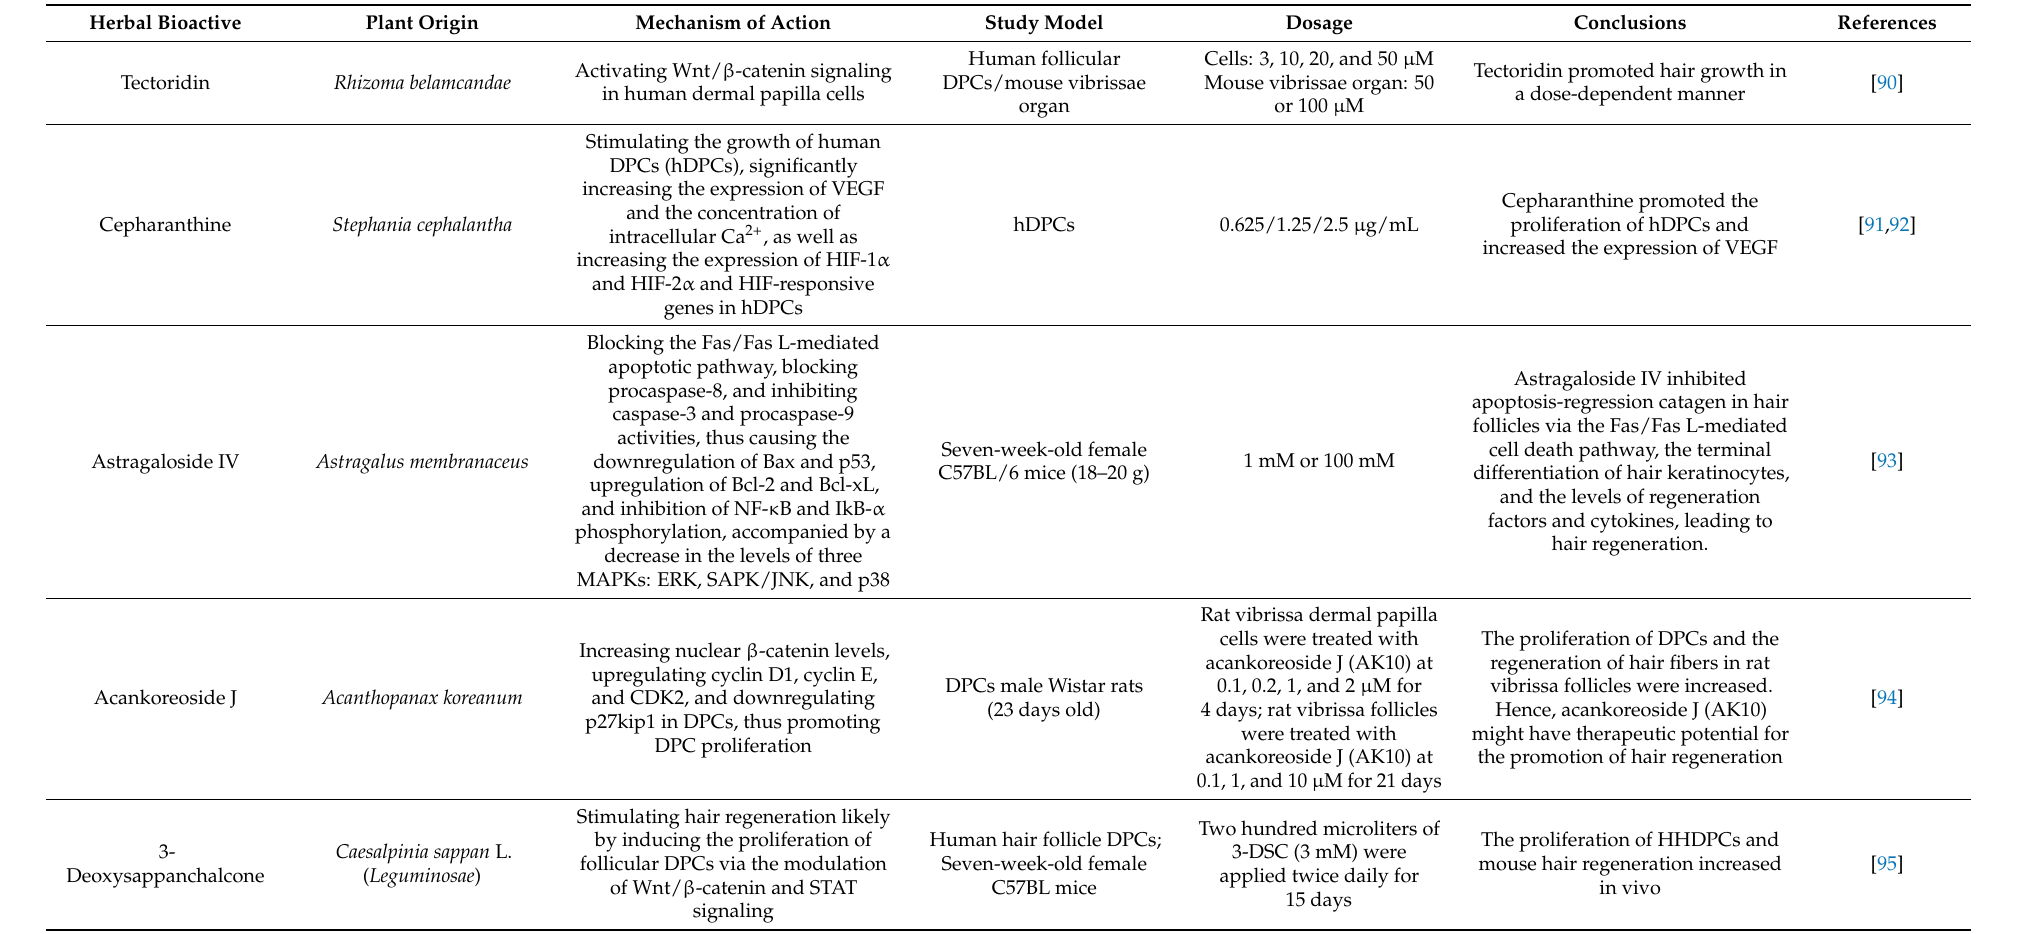
Table 4. Natural products for hair